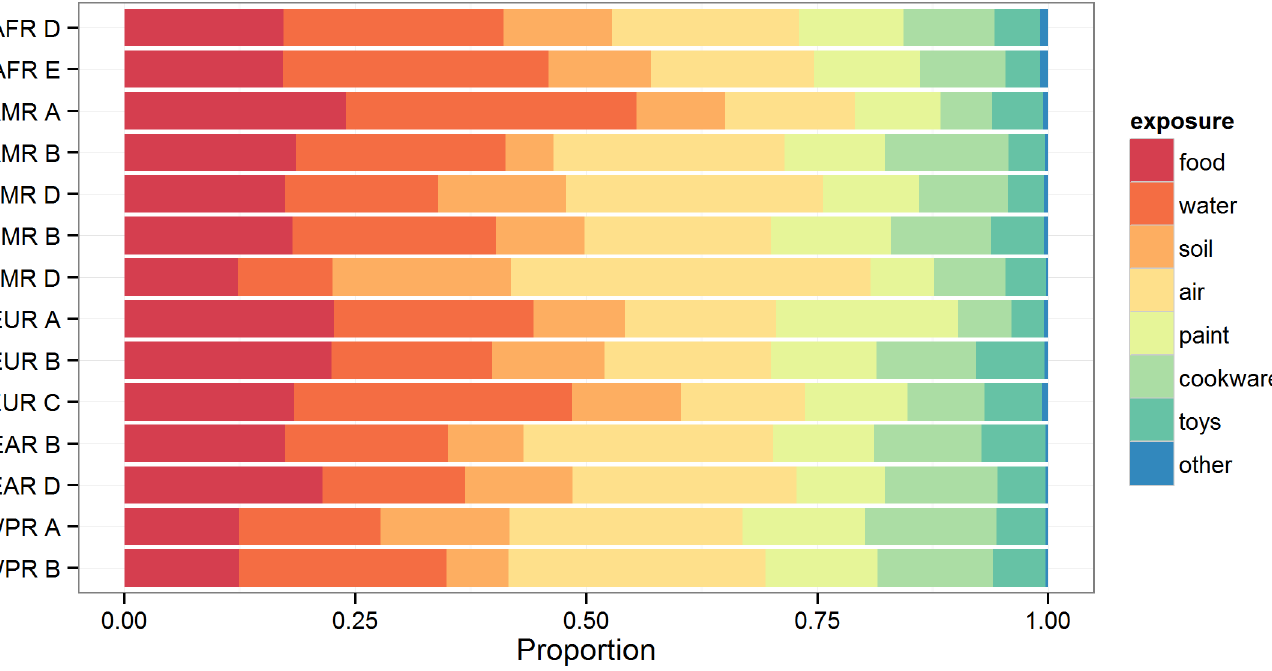
Fig 8. Subregional estimates (medians) of the proportion of disease caused by exposure to lead through eight different exposure routes.